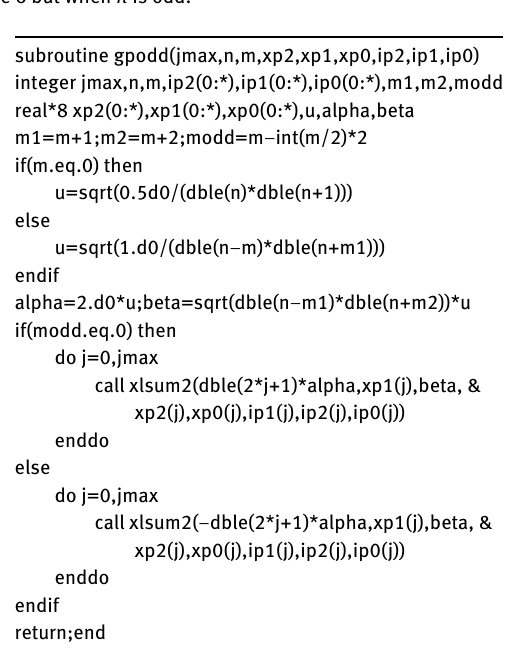
Table 7: Fortran subroutine to return P nmj when n is odd. Same as Table 6 but when n is odd.